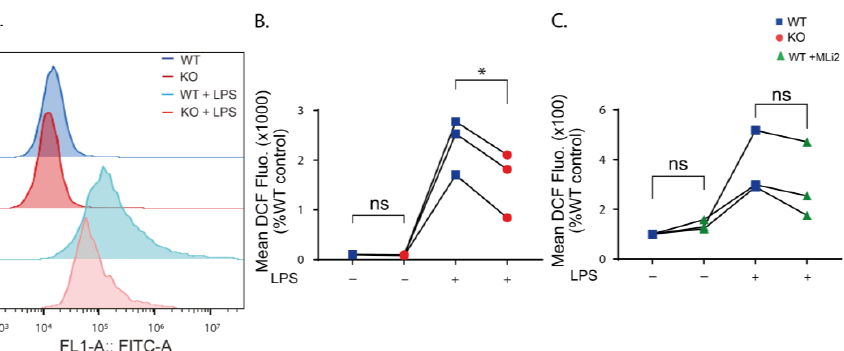
Figure 3. Cellular ROS levels are reduced when LRRK2 is absent or its kinase function is inhibited. ( A ) Histogram showing representative FACS sample analysis of WT and KO cells with and without LPS stimulation for 24 h using DCFDA. ( B ) Analysis of the mean DCF fluorescence in the KO cells without and with LPS stimulation normalized to the control WT. ( C ) Analysis of the mean DCF fluorescence in the MLi2-treated WT cells without and with LPS stimulation normalized to the control WT. The experiment was performed 3 times and one-way ANOVA was used to compare the mean DCF fluorescence relative to the control WT. p -values indicating statistically significant differences between the mean values are defined as follows: ns—not significant, * p <